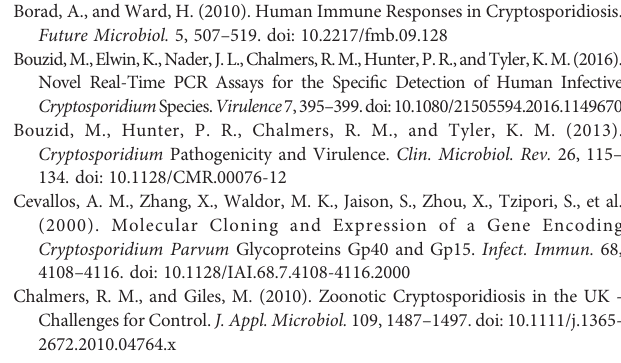
Supplementary Table 1 | Distribution of cases and controls by hospital of origin. Supplementary Table 2 | Peptide antigens of the Cryptosporidium parvum gp15 and gp40 proteins. Supplementary Figure 1 | Recognition of peptides among infecting Cryptosporidium species. The line is cut-off (average plus two standard deviations) for each peptide obtained from the average of the absorbances of the controls. Cp, C. parvum ; Ch, C. hominis ; Cc, C. canis . (A) Peptide A109. (B) Peptide A133. (C) Peptide V30. (D) Peptide A32. (E) Peptide R61. Supplementary Figure 2 | IgM and IgG anti- Cryptosporidium A133 peptide. (A) Cases. (B) Controls. (C) Cases with IgG above the cutoff line (0.5). (D) Controls with IgG above the cut-off line (0.5). (E) Cases with IgG below the cutoff line (0.5). (F) Controls with IgG below the cutoff line. Supplementary Figure 3 | IgM and IgG anti- Cryptosporidium A32 peptide. (A) Cases. (B) Controls. (C) Cases with IgG above the cutoff line (0.556). (D) Controls with IgG above the cut-off line (0.05). (E) Cases with IgG below the cutoff line (0.05). (F) Controls with IgG below the cut-off